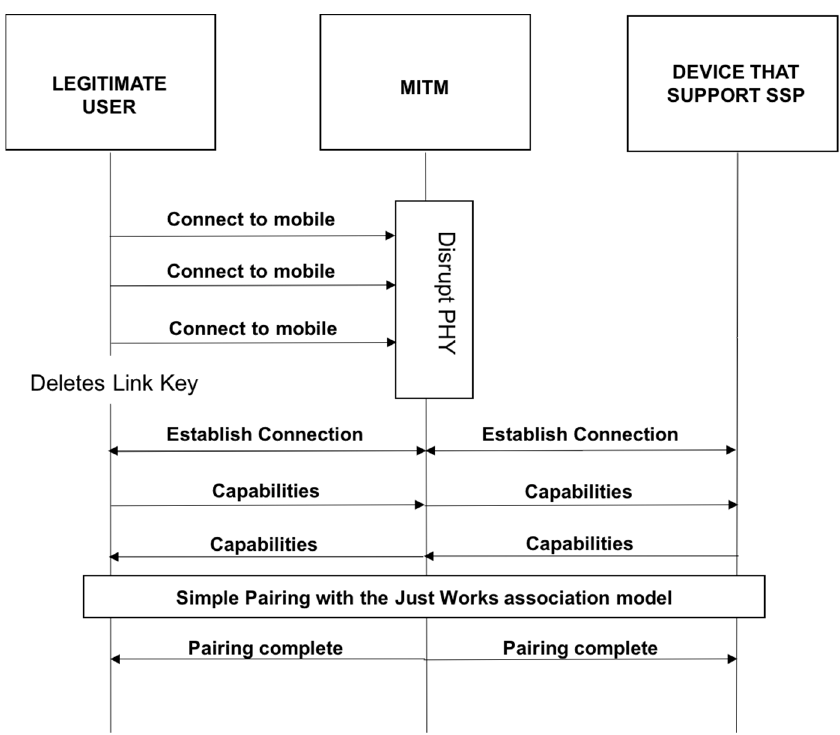
Figure 9. Man-in-the-Middle Attack.